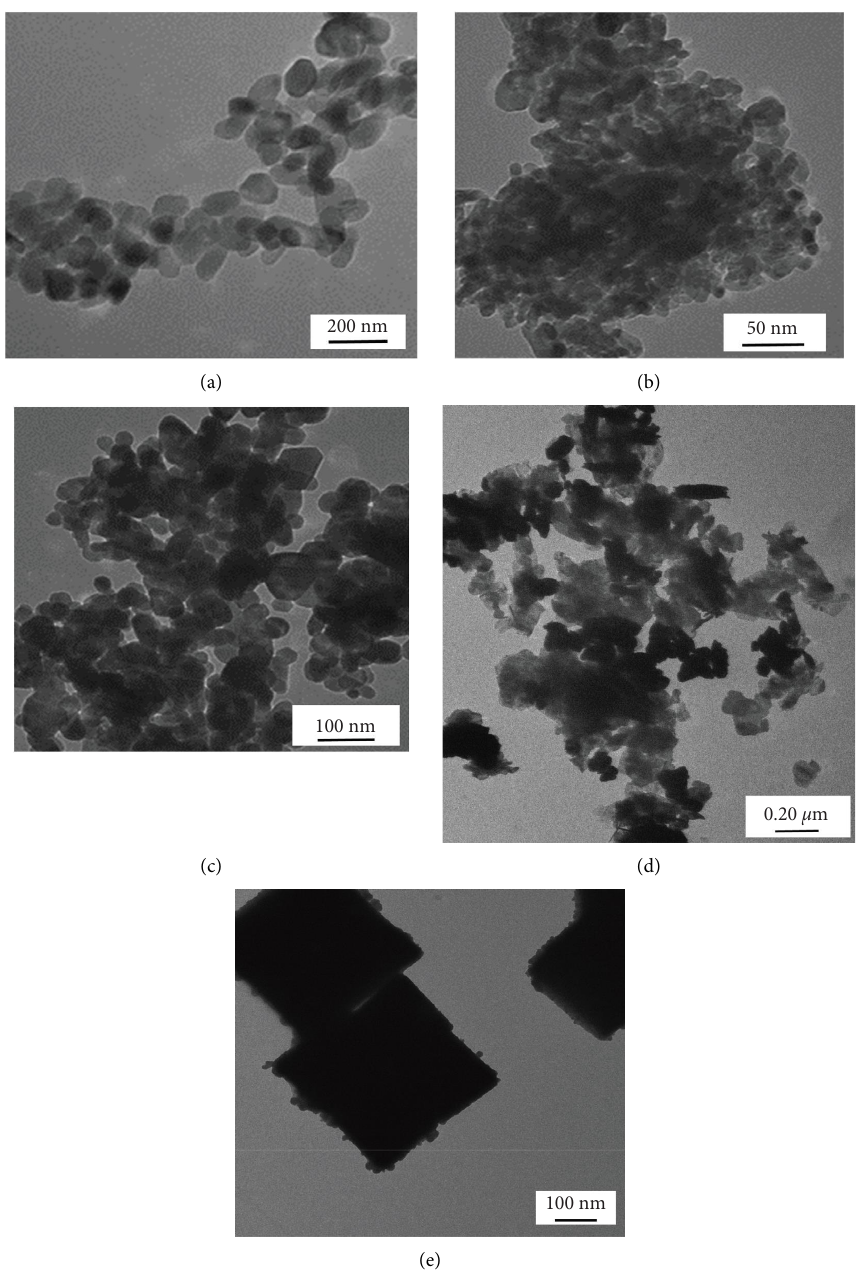
Figure 1: TEM images of ENPs used in this study: (a) Ag, (b) TiO